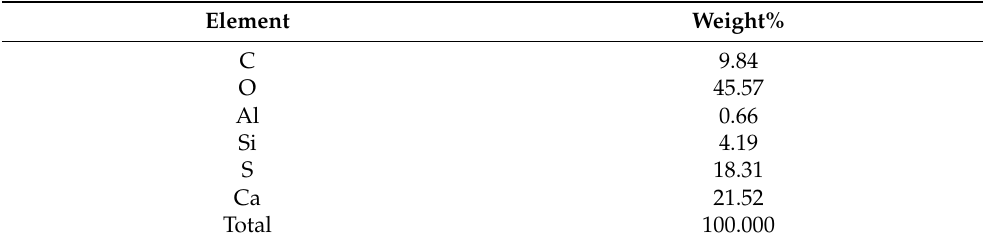
Table 5. Elemental composition of Ca-rich zeolites synthesized from